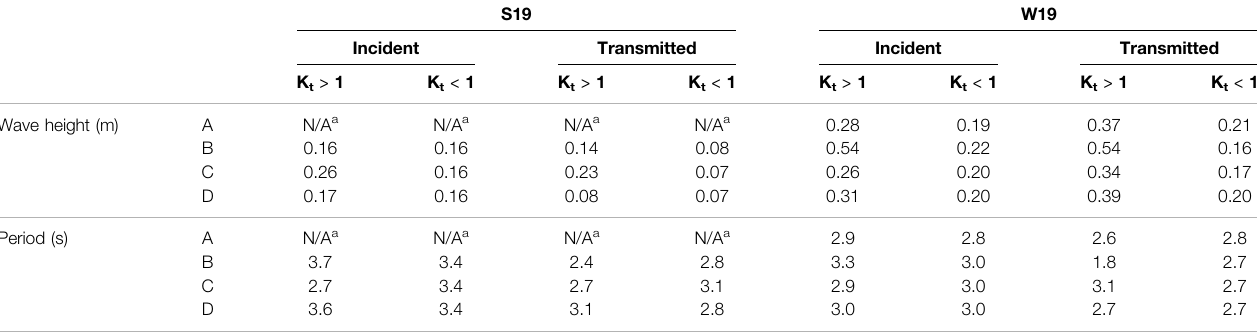
TABLE 2 | Average signi fi cant wave height and period during S19 and W19 for both incident and transmitted waves during instances of ampli fi cation (K t > 1) and reduction (K t <